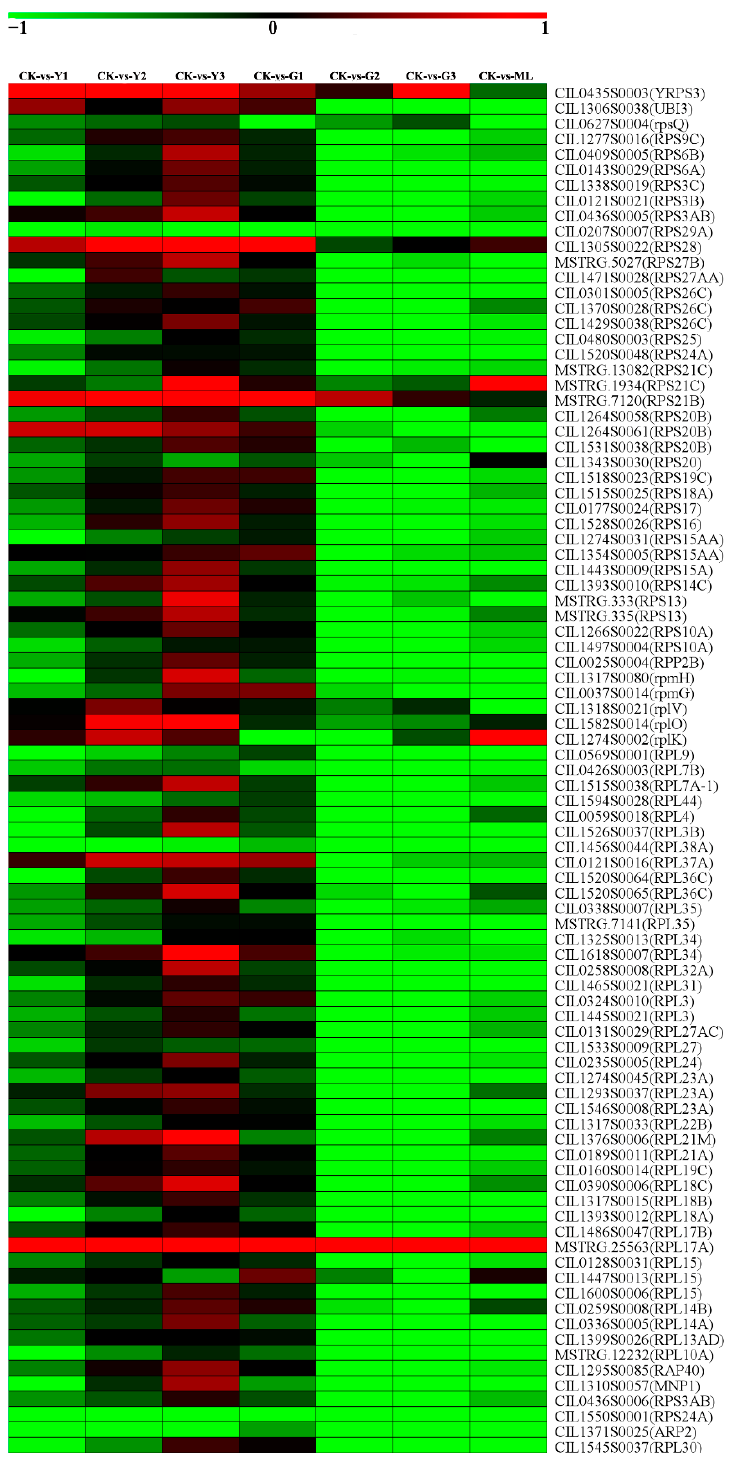
Figure 13. Heat map of DEGs of ribosome pathways (Ko03010). Responsive progression of genes expressions under different samples infection PMV compared to CK. Heat maps were drawn using the Log2 ratio (transformed FPKM value of PMV infection/those of CK). Detailed genes and expressions data are provided in Table S20, available as Supplementary Data online. The heat maps indicated the upregulation (red) and downregulation (green) of genes in PMV-infected samples compared to CK. A total of 19 DEGs of ribosome biogenesis in eukaryotes (Ko03008) were obtained in PMV-infected samples compared to CK (Table S21). A total of 11 out of 19 genes